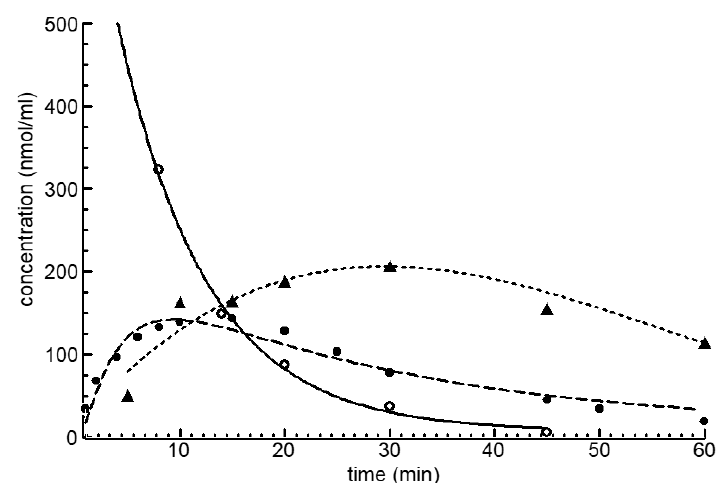
Figure 2. Blood level curves of CP ( ○ ), OHCP ( ● ) and detoxification products KCP plus CARB ( ▲ ) after intravenous injection of 100 mg/kg CP in female NMRI mice. CP is eliminated from the blood with a half-life of 6 min. This corresponds to the half-life of the formation of OHCP of 5 min. The detoxification products KCP and CARB accumulate because they are eliminated from the blood with elimination half-lives of 41 and 20 min more slowly than OHCP for which an elimination half-life of 16 min was calculated. Table 1. Balance of cyclophophamide metabolism in female NMRI mice after the intravenous administration of 100 mg/kg cyclophosphamide calculated from the mean of 5–8 female NMRI mice. The 2nd column in the % column indicates how much of the OHCP formed is oxidized to KCP and Carb.